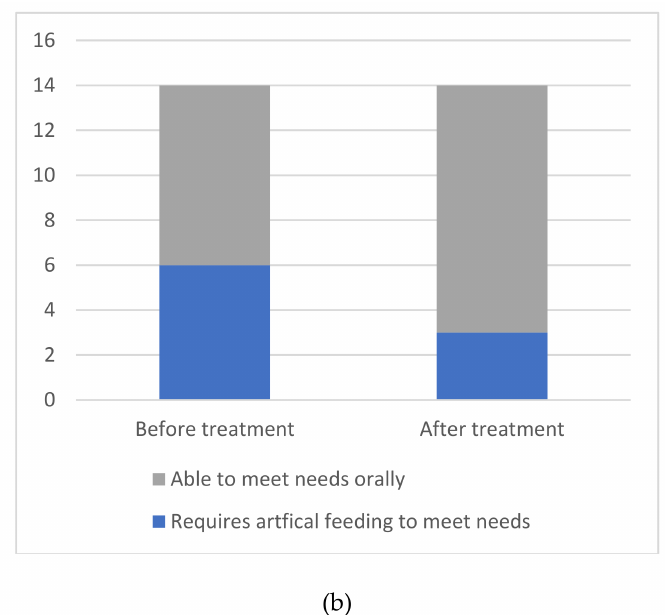
Figure 3. ( a ) Number of stroke patients dependent on artificial feeding before and after completion of the NMES therapy programme. ( b ) Number of non-stroke patients dependent on artificial feeding before and after completion of the NMES therapy